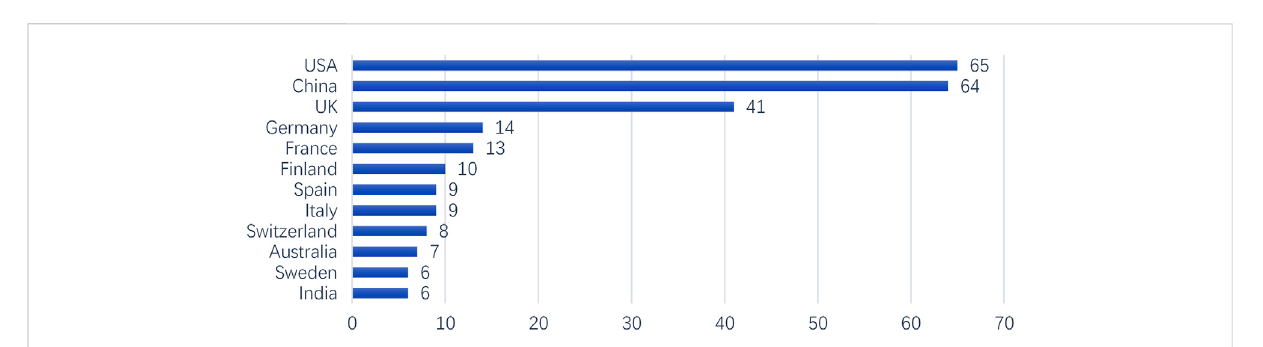
FIGURE 5 Number of articles across countries.